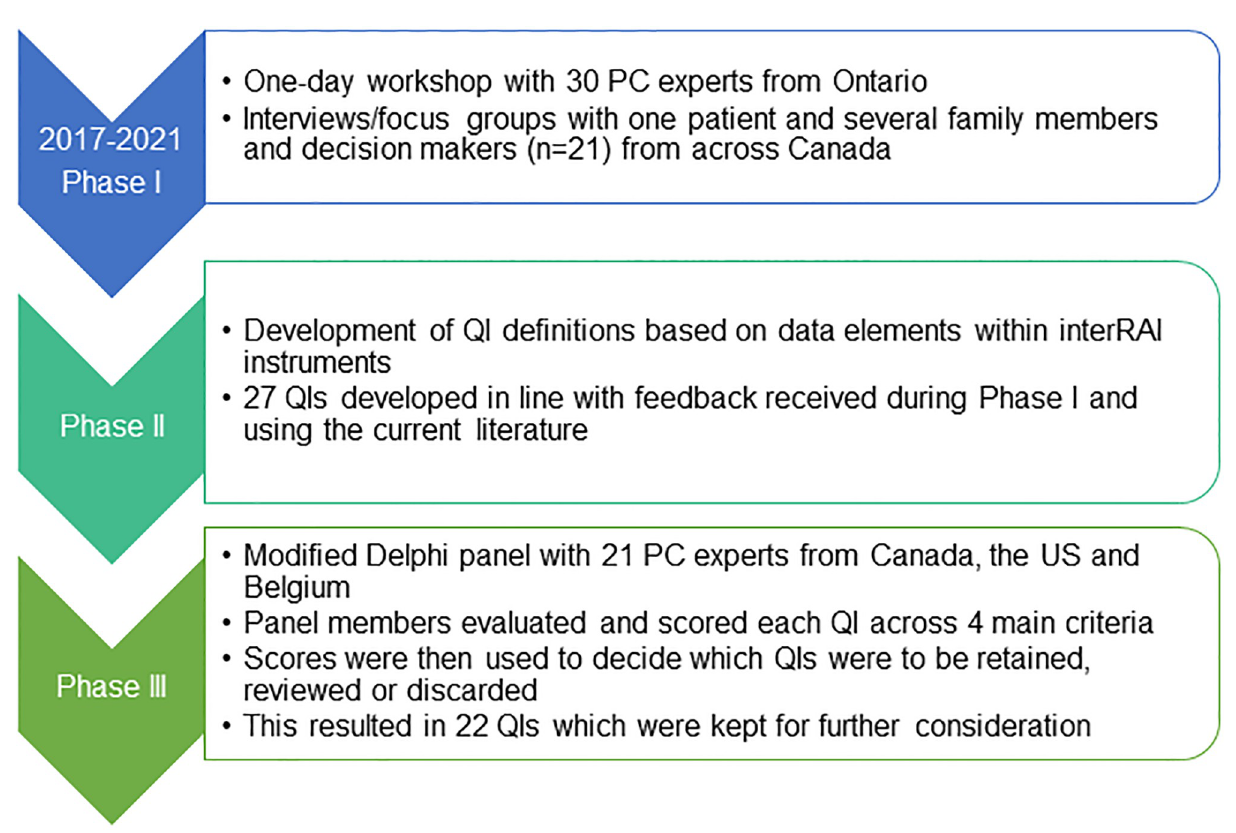
Fig 1. Summary of the steps in the QI development